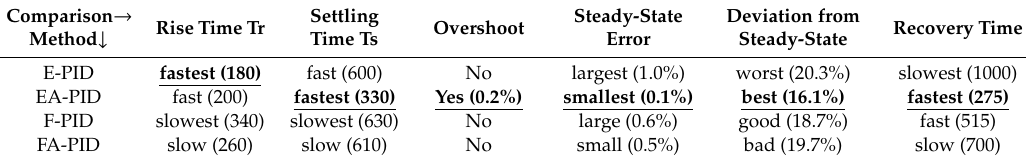
Table 6. Comparison of simulation results of control system